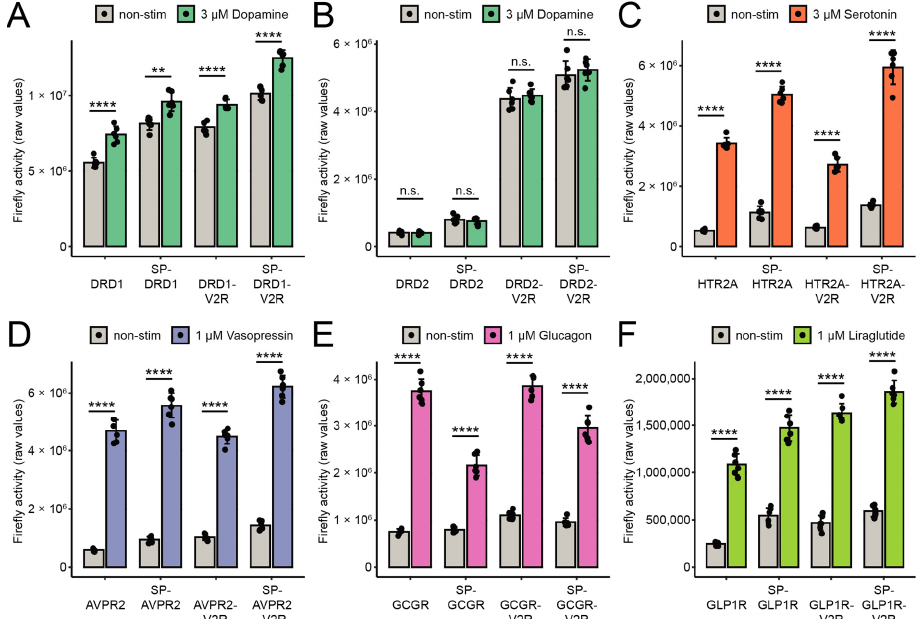
Figure 3. Split TEV GPCR β -arrestin-2 recruitment assays in PC12-TO cells. ( A – F ) Luciferase end- point assays for DRD1 ( A ), DRD2 ( B ), HTR2A ( C ), AVPR2 ( D ), GCGR ( E ), and GLP1R ( F ). All assays were conducted in a 96-well format. Assays were stimulated for 6 h with their agonists. Bar graphs display the means; the error bars represent the s.d. with six replicates per conditions. A two-tailed Student’s t test was used to determine the p -values for treatment versus control. ** p ≤ 0.01; **** p ≤ 0.0001, n. s., not significant. Table 1. Robustness of split TEV GPCR assays. Fold-change and Z’-factor values of all split TEV GPCR β -arrestin-2 assays that were conducted in HEK-293, HeLa, U 2-OS, and PC12-TO cells.